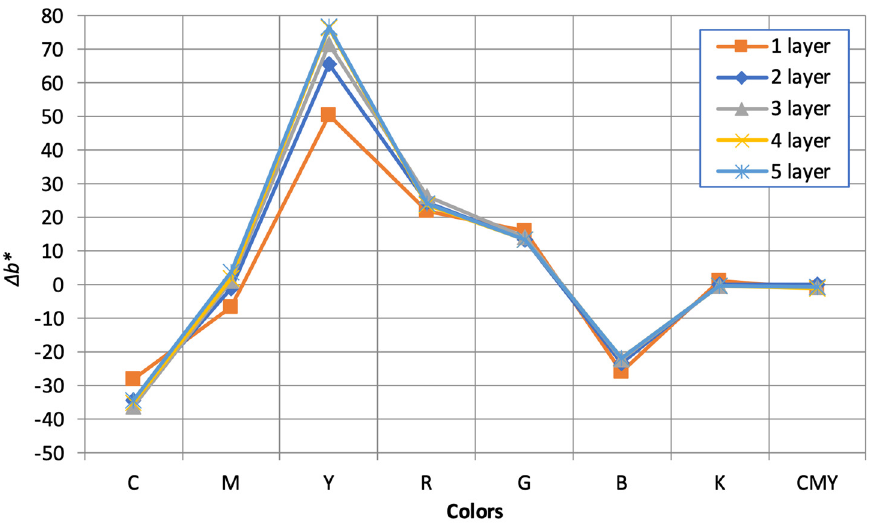
Figure 10. Different colors changes of Δ b * depending on ink layer when printing in 4 passes.